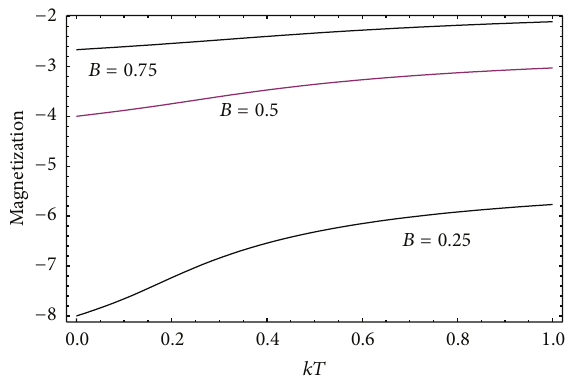
Figure 2: In this case, only dipole excitation is considered and magnetic susceptibility curves along easy axes (𝜑 = 0) and hard axes (𝜑 = 𝜋/2) are similar.